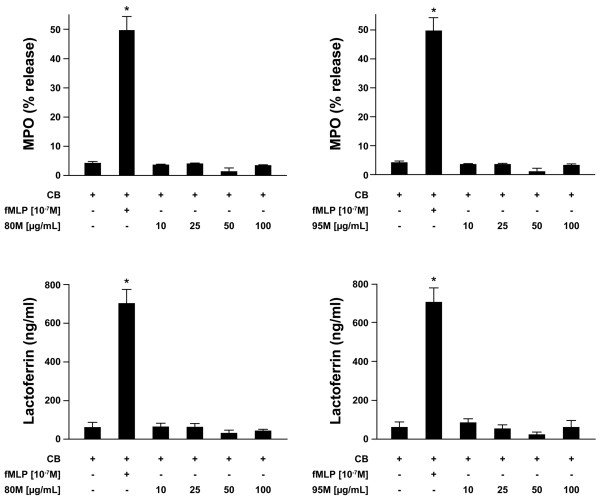
Release of myeloperoxidase and lactoferrin by PMNs in response of chitosan. Degranulation was determined using the (a, b) myeloperoxidase (MPO) and (c, d) lactoferrin assay, as described in 'Materials and Methods'. Freshly isolated polymorphonuclear neutrophils (PMNs) resuspended in RPMI 1640 supplemented with 0.1% decomplemented fetal bovine serum were treated with cytochalasin B and further incubated with the indicated concentrations of 80% deacetylated (80 M; panels a and c) or 95% deacetylated (95 M; panels b and d) chitosan for 30 minutes at 37°C. The quantity of MPO released is expressed as '% MPO', which corresponds to the ratio of the amount of MPO released/total amount of cellular MPO. The amount of lactoferrin released is expressed in ng/ml. Results are presented as mean ± standard error. The difference from the negative control is statistically significant: *P < 0.001 (Tukey-Kramer test). The negative control = PMNs incubated in Hanks' Balanced Salt Solution supplemented with 0.1% decomplemented fetal bovine serum and incubated with cytochalasin B. This figure represents the results of at least three independent experiments. fMLP, N-formyl-methionyl-leucyl-phenylalanine.